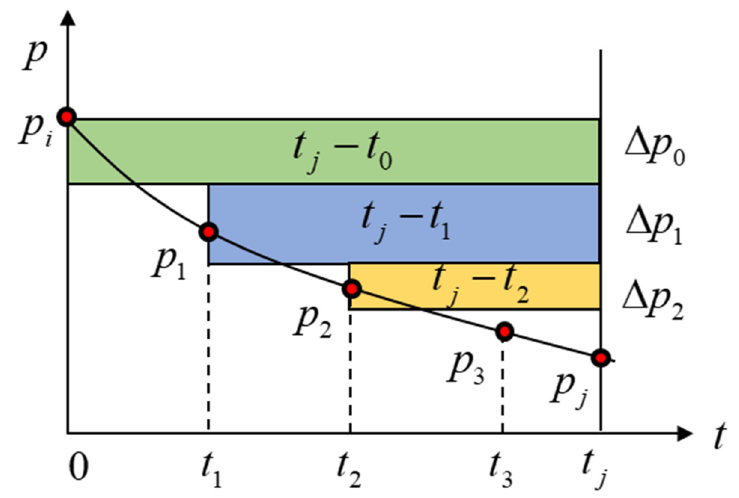
Figure 10. Pressure drop curve.